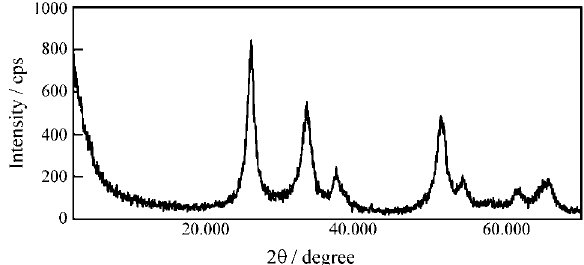
Figura 6b. Difractograma de rayos X de la muestra sólida obtenida a pH 4.6 de la disolución 0.2 M de SnCl 2 .